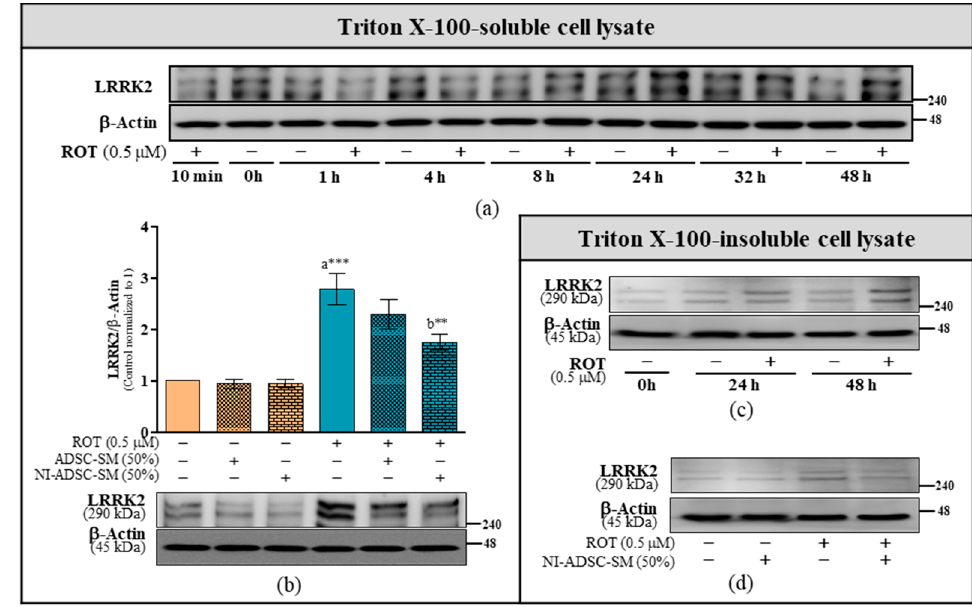
Figure 2. Effects of the NI-ADSC-SM on LRRK2 expression. ( a , c ) Cells were treated with or without ROT (0.5 μ M) at different timepoints as depicted in Supplementary Figure S1a, and LRRK2 protein expression in Triton X-100-soluble ( a ) and Triton X-100-insoluble ( c ) cell lysate fractions were as- sessed by Western blotting. ( b , d ) Cells were incubated in the presence of ROT (0.5 μ M) or DMSO for 48 h alone or with the ADSC-SM or NI-ADSC-SM (each diluted by 50%) during the last 24 h. LRRK2 protein expression in Triton X-100-soluble ( b ) and Triton X-100-insoluble ( d ) cell lysate frac- tions was assessed by Western blotting. Data are shown as the means (bars) and SEM (error bars) of three independent cell culture experiments. Statistical analysis was performed using one-way ANOVA with Tukey’s post-test. Statistical comparisons: a—compared with control; b—compared with ROT; ** p < 0.01 and *** p < 0.001. 2.3. Effects of the NI-ADSC-SM on PINK1 and Parkin Protein Expression after ROT Exposure PINK1 and parkin promote mitochondrial health. In this study, the ROT exposure decreased PINK1 (Figure 3a; Figure 3b: p < 0.05) and parkin (Figure 3a; Figure 3c: p < 0.01) expression at 48 h in SH-SY5Y cells. Treatment with the NI-ADSC-SM or ADSC-SM in- creased parkin ( p < 0.05) levels after ROT exposure (Figure 3c), though they had no effect on PINK1 (Figure 3b). Moreover, neither the ADSC-SM nor NI-ADSC-SM altered PINK1 or parkin expression in the control groups. These results suggest that the NI-ADSC-SM can rescue parkin expression after ROT exposure and may impede dysfunctional mitoph- agy and the parkin-mediated signaling pathway.